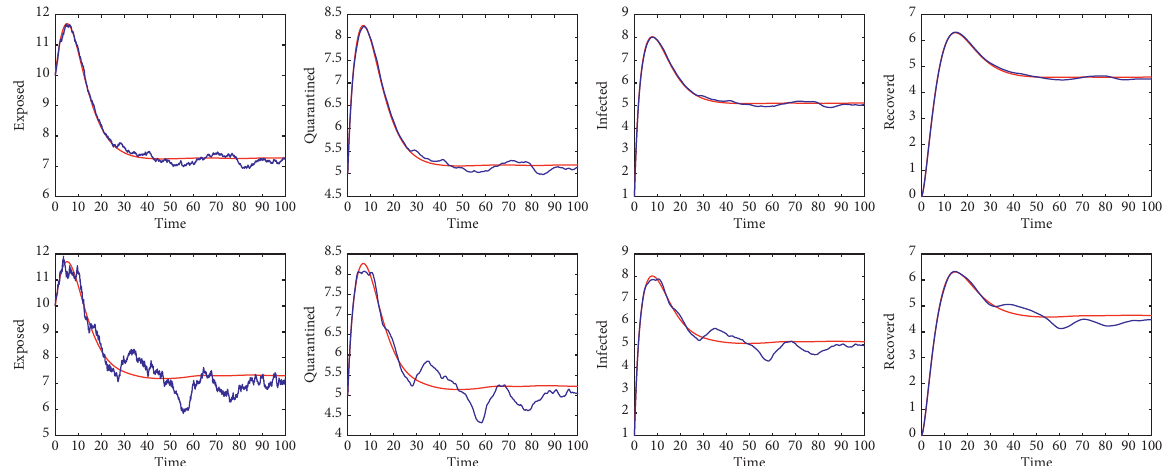
Figure 3: The asymptotic solutions of the deterministic and stochastic system. The first row is the case of σ � 0 . 01, and the second row is the case of σ � 0 . 04. Table 1: Description and values of parameters.